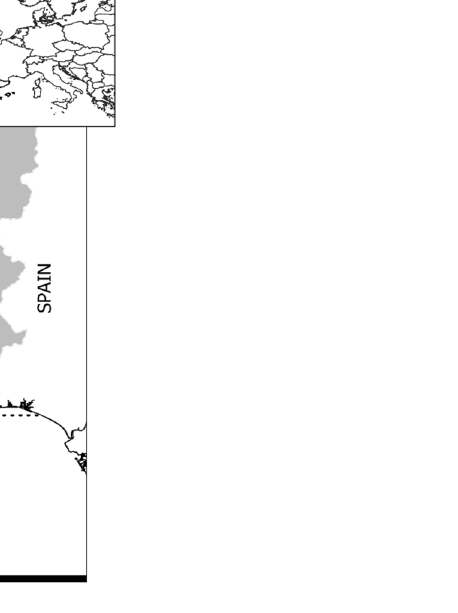
Figure 1. Map of Portugal showing the regions of study. The map was created using QGIS 3.10